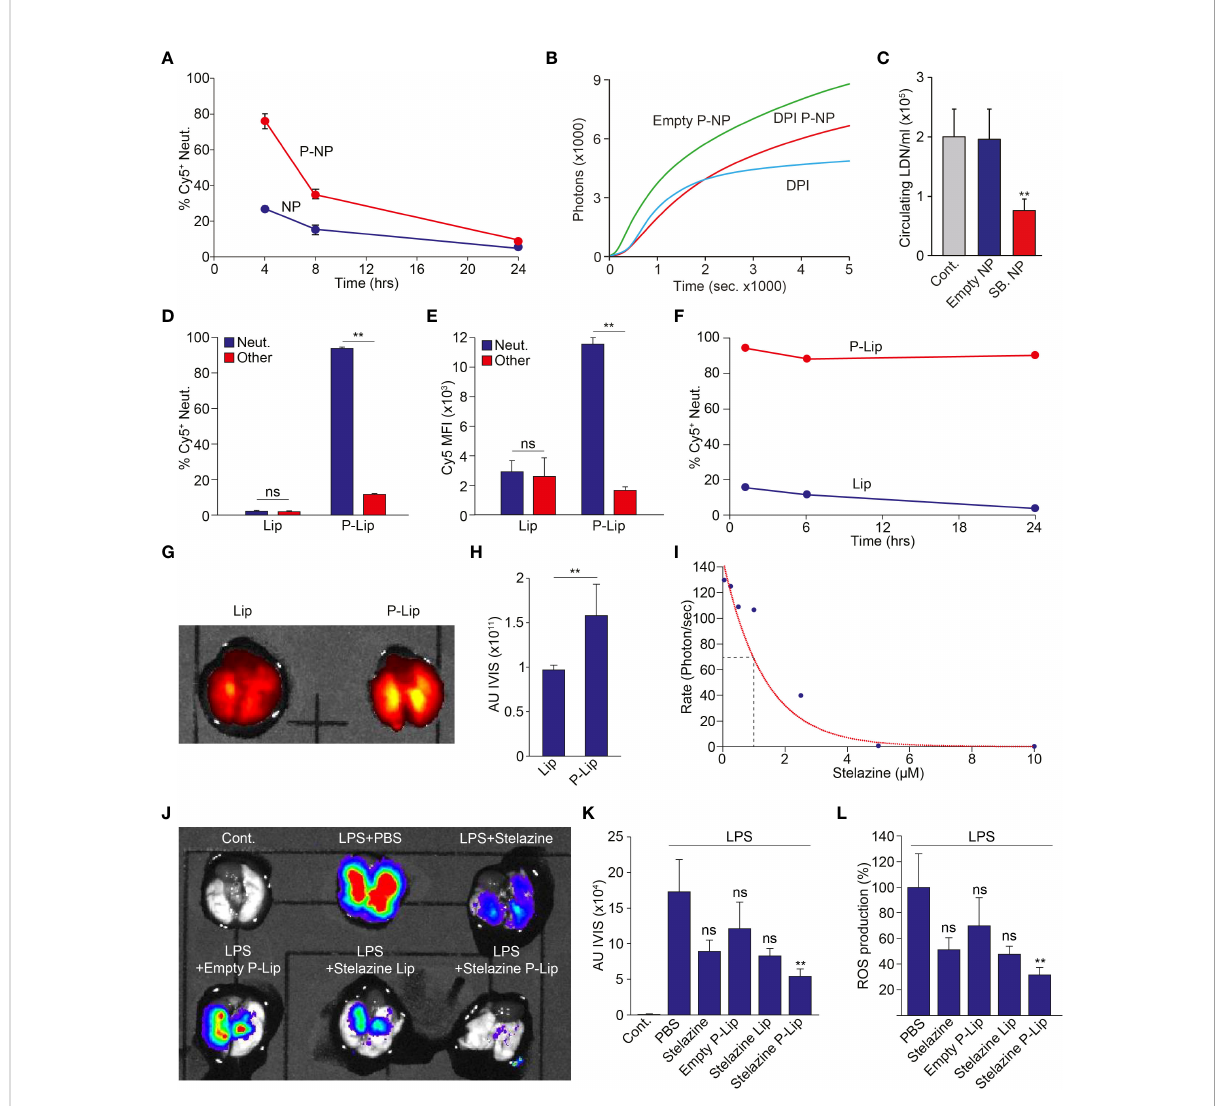
FIGURE 4 Modulation of Neutrophil Function In Vivo. (A) NP containing neutrophils in healthy Balb/C mice injected i.v. with either NP or P-NP at 4, 8 and 24 hours post injection (n=2 per group). (B) Healthy Balb/c mice were intraperitoneally injected with Zymosan-A to induce peritonitis. These mice were then i.v. injected with free DPI, empty P-NP or DPI containing P-NP. The peritoneal neutrophils were then isolated and stimulated with PMA (100 nM). Graph shows the extent of H 2 O 2 production in neutrophils isolated from treated mice following PMA stimulation. (C) SB431542-containing P-NP limit the propagation of circulating low density neutrophils in 4T1 tumor bearing mice, indicating effective blocking of TGF b in vivo (19). Control mice (Cont.) were untreated and mice treated with empty P-NP (Empty NP) served as control for P-NP injection. (D) The extent of targeting Cy5 + Lip and P-to neutrophils (blue) or other WBCs (red) 4 hrs post i.v. administration (n=4 per group). (E) The relative uptake (Cy5 MFI) of Cy5 + Lip and Cy5 + P-Lip by neutrophils (blue) or other WBCs (red) 4 hrs post i.v. administration (n=4 per group). (F) Lip-containing neutrophils in healthy Balb/C mice injected i.v. with either Lip or P-Lip at 1, 6 and 24 hours post injection (n=4 per group). (G) Representative imaging of Cy5 emanating from the lungs of mice with ARDS treated with Cy5 + Lip or Cy5 + P-Lip. (H) Average intensity